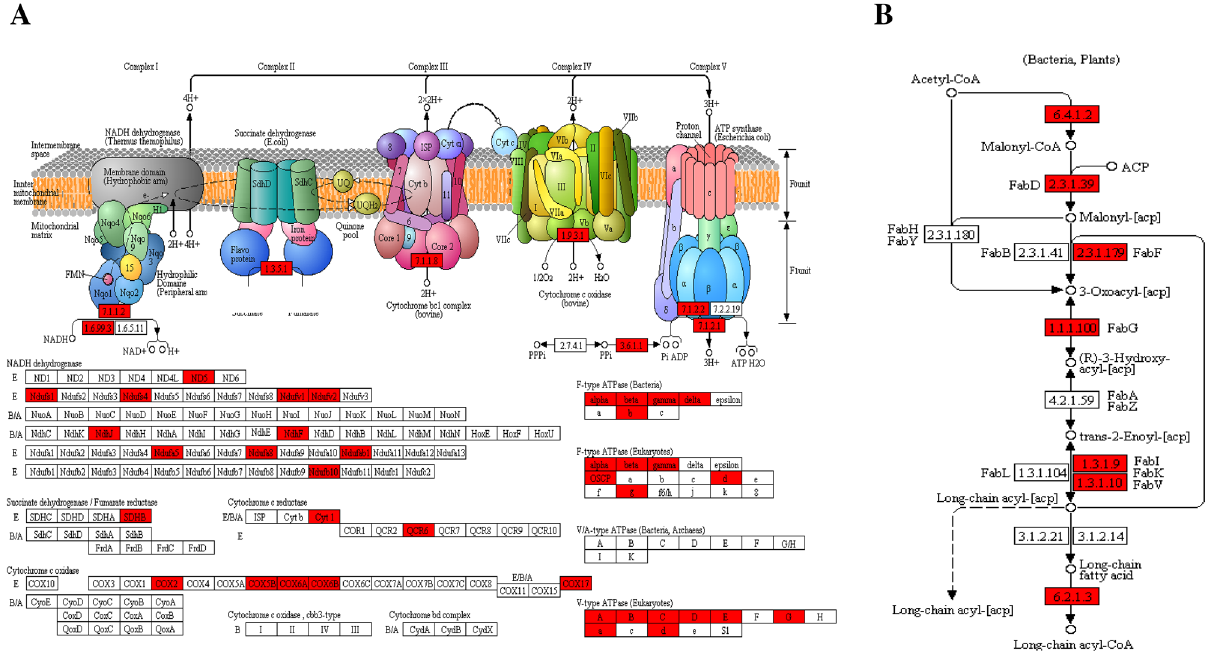
Figure 6. Representative significantly enriched KEGG pathways. ( A ) Oxidative phosphorylation. ( B ) Fatty acid biosynthesis. The Kac proteins are labeled in red. The figures were prepared with referring KEGG pathway map images with